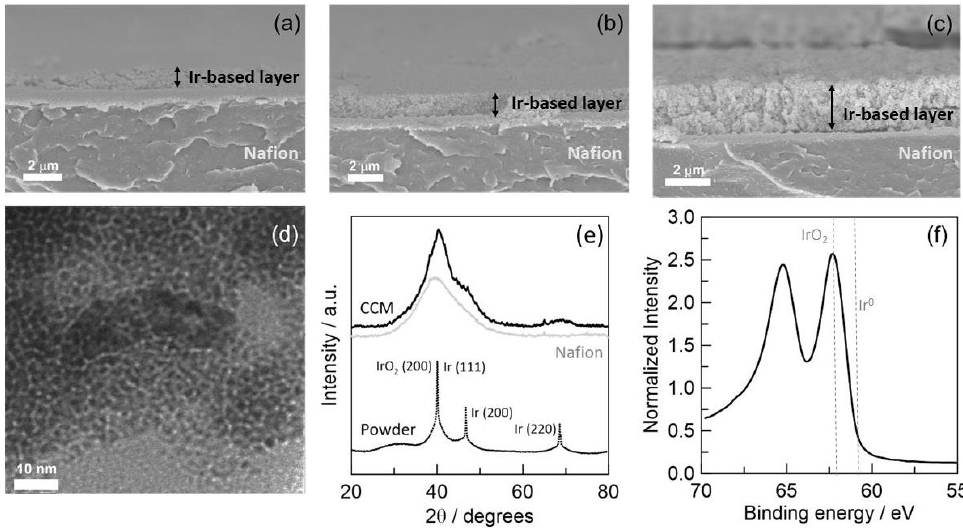
Figure 1. Physicochemical characterization of anode-coated spark-ablation CCMs. ( a – c ) Cryo-fractured SEM cross-sections for different anode loadings, showing the uniformity and thickness of IrO x layers, ( d ) TEM image showing the size of IrO x nanoparticles (sample with Ir loading of 0.8 mg cm −2 ), ( e ) XRD pattern of CCM, powder catalyst and Nafion membrane ( f ) XPS Ir 4f spectrum.